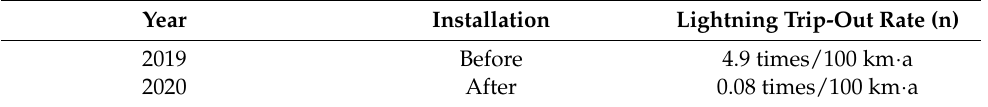
Table 8. Lightning outage rate of the transmission